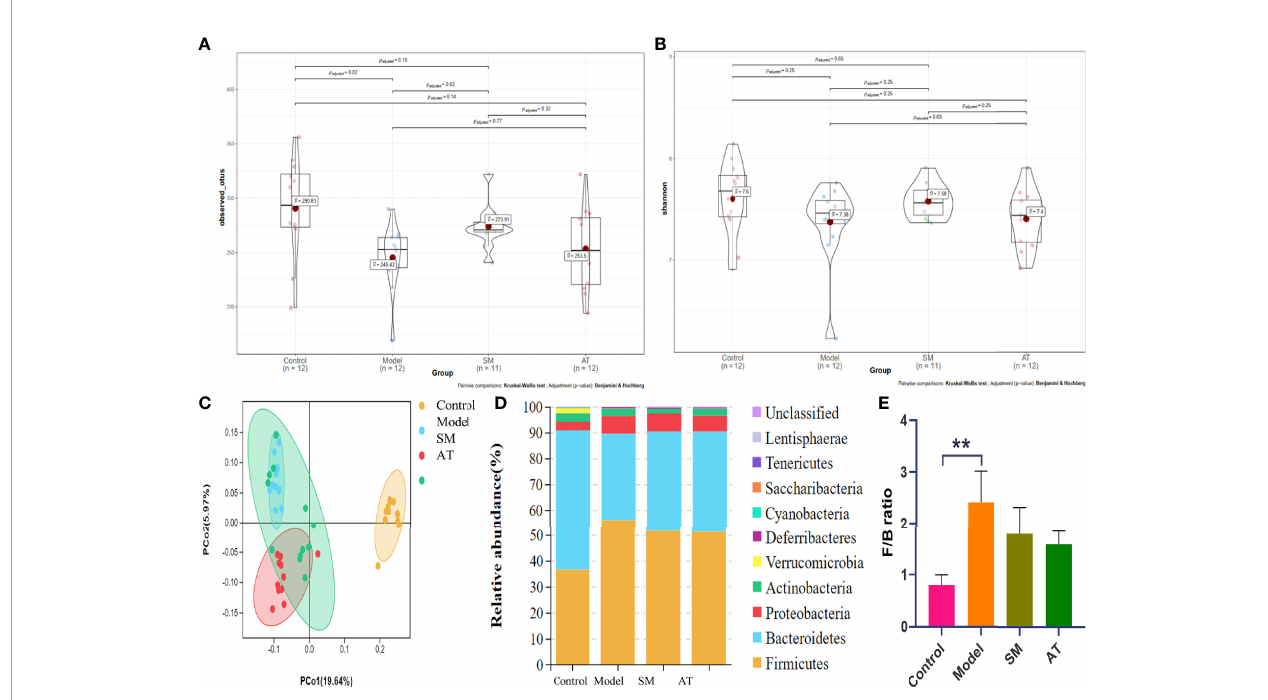
FIGURE 3 | (A) The box plots of observed operational taxonomic unit (OTU) number. (B) Boxplot of Shannon diversity indices for the four groups. (C) Unweighted UniFrac PCoA results for all samples. (D) Stack bar charts of species distribution at the phylum level. (E) Ratio of Firmicutes to Bacteroidetes (F/B). **: signi fi cant difference (P <